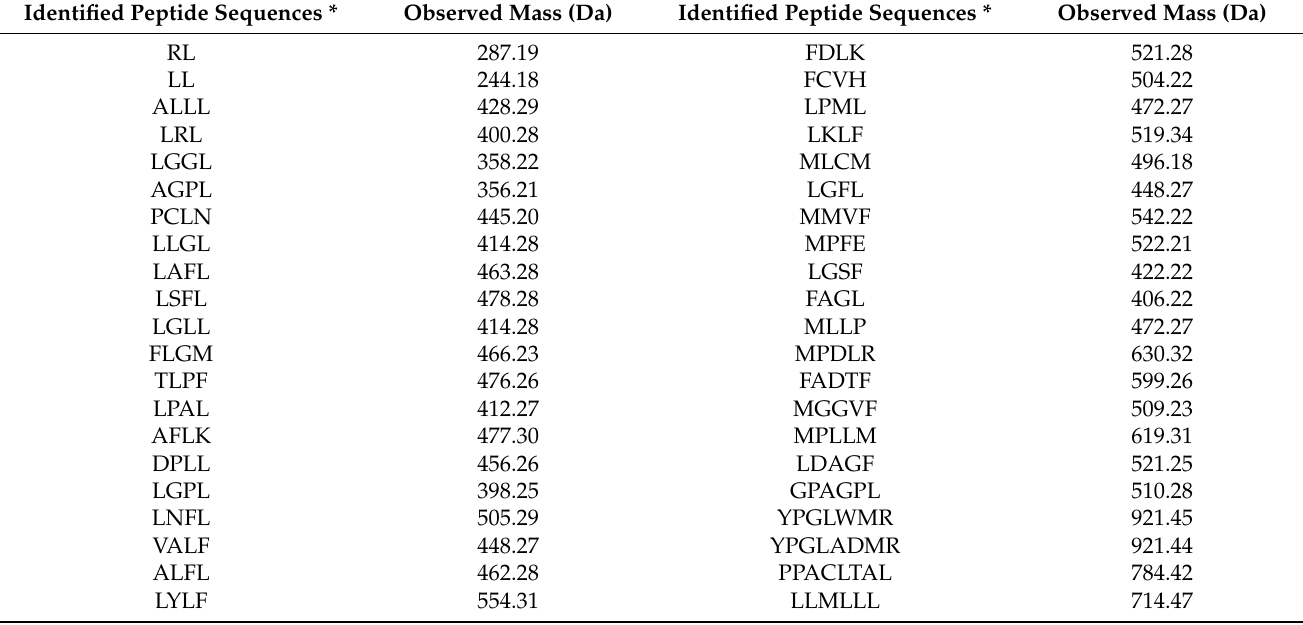
Table 5. Potential bioactive peptides in HB-IV fraction as ranked using